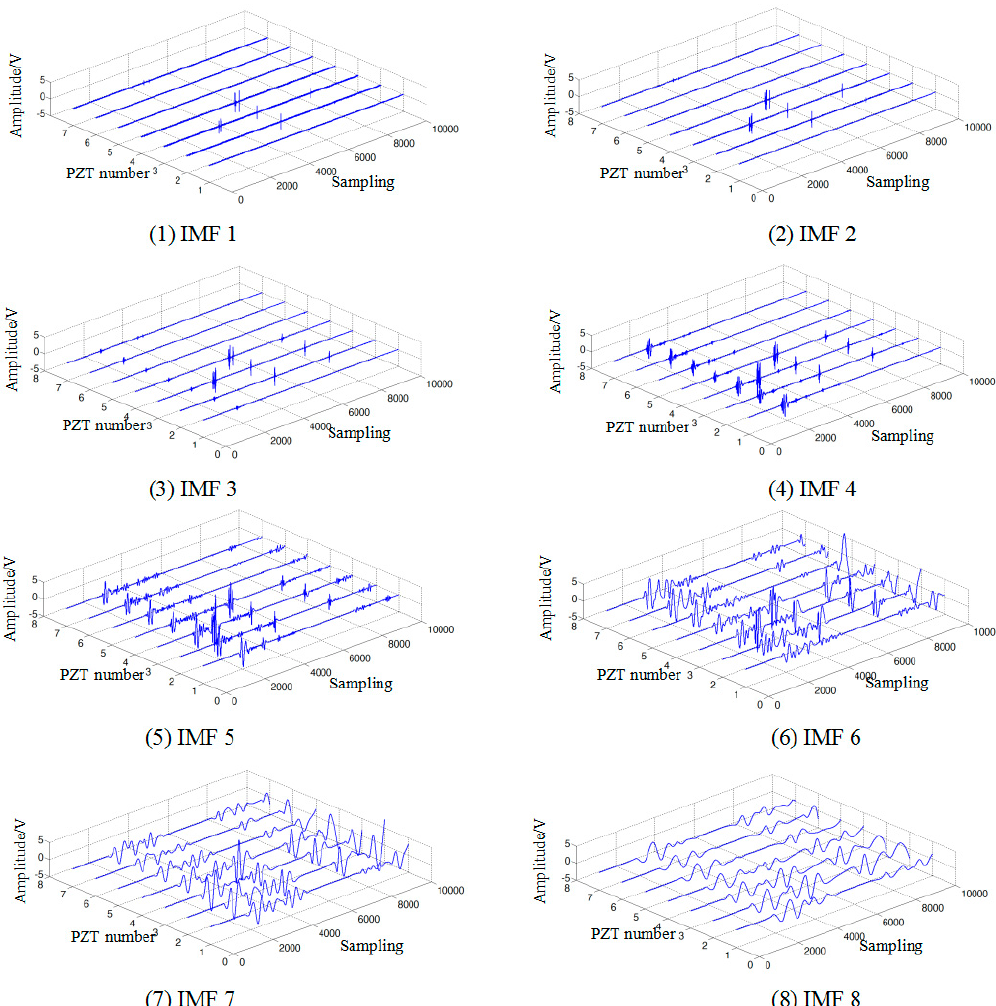
Figure 4. The IMFs using the optimized EEMD to decompose the impact array signals.